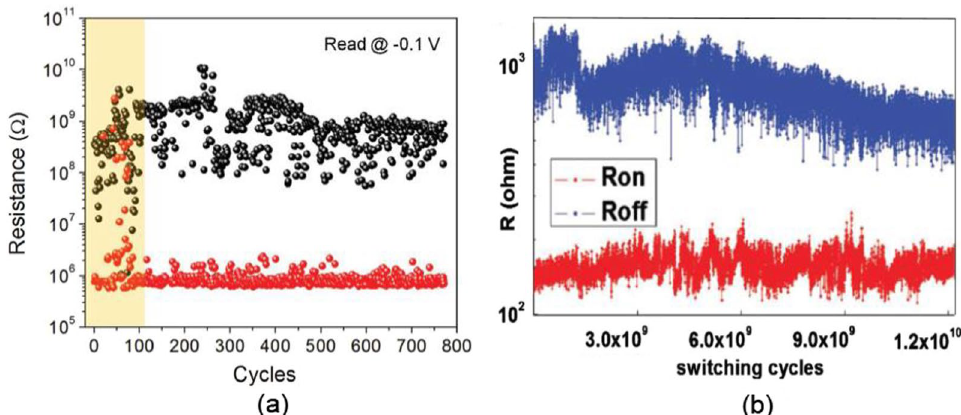
Fig. 10 RRAM endurance plots obtained by two methods. a Measuring various I–V curves and extracting resistance at − 0.1 V. Reproduced with permission [79] Copyright 2017, Wiley-VCH. b By using pulse stresses recording the current simultaneously and calculating the resist- ance for each cycle (namely current-visible PVS). Reproduced with permission from [80]. Copyright 2010, American Institute of